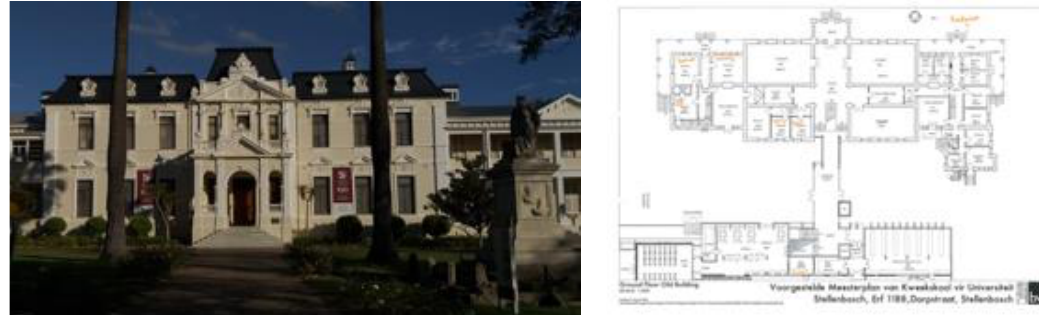
Figure 7 : The Theology Building